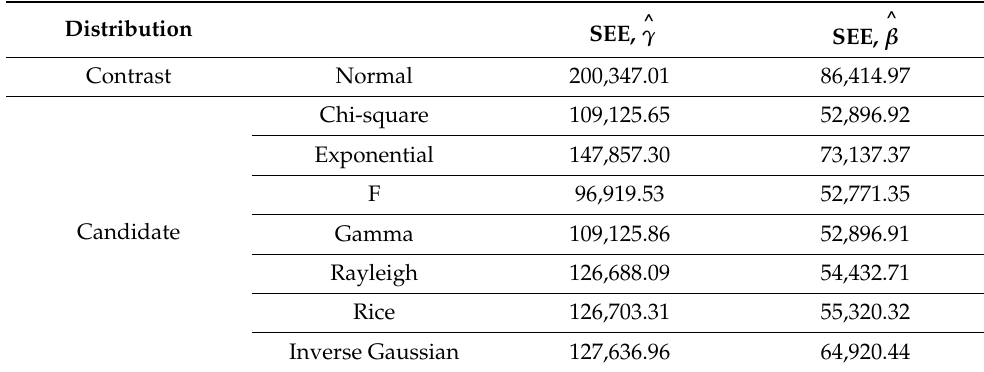
Table 2. Estimated probability densities for ˆ γ and ˆ β